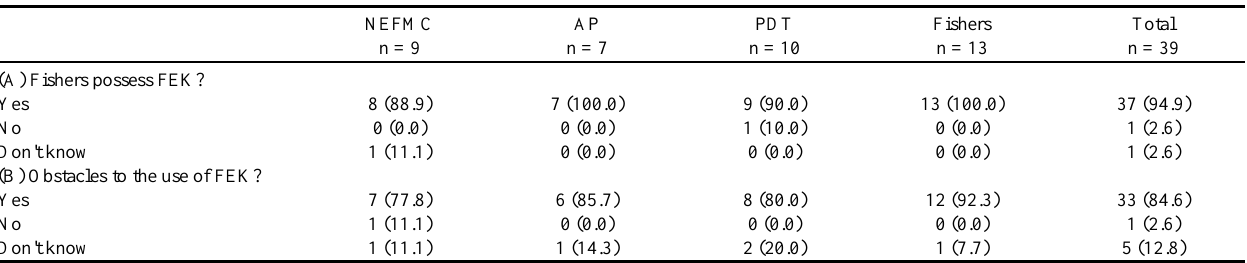
Table 5 . Opinion about fishers’ ecological knowledge (FEK) for each of the surveyed groups: (A) Do fishers possess FEK? (B) Are there obstacles to the use of FEK in fishery management? Values in parentheses are percentages. NEFMC n =